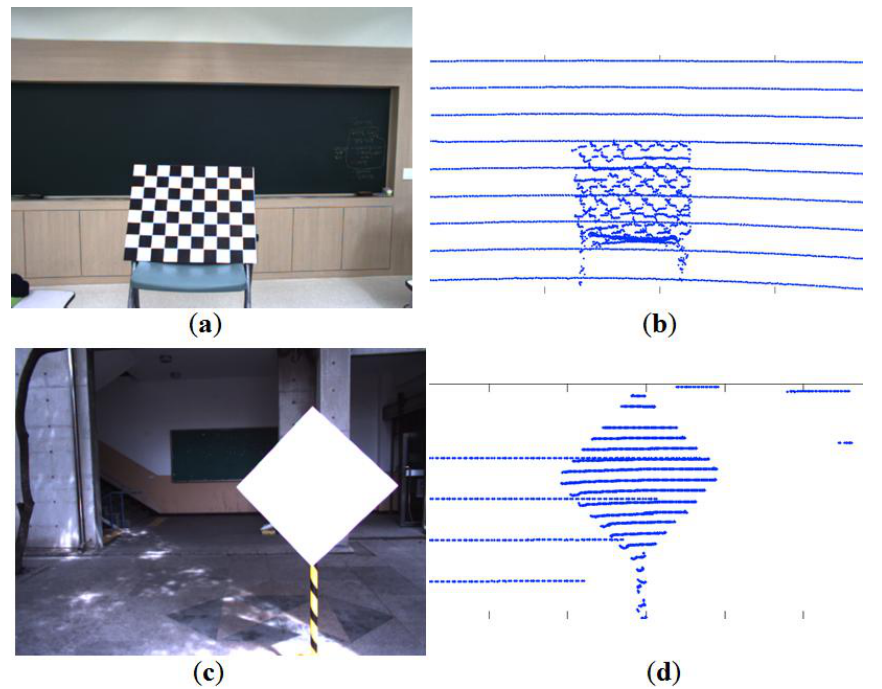
Figure 1. Velodyne HDL-32E scanning on checkerboard and monochromatic board: ( a ) Checkerboard; ( b ) Scanned data of (a); ( c ) Monochromatic board; ( d ) Scanned data of